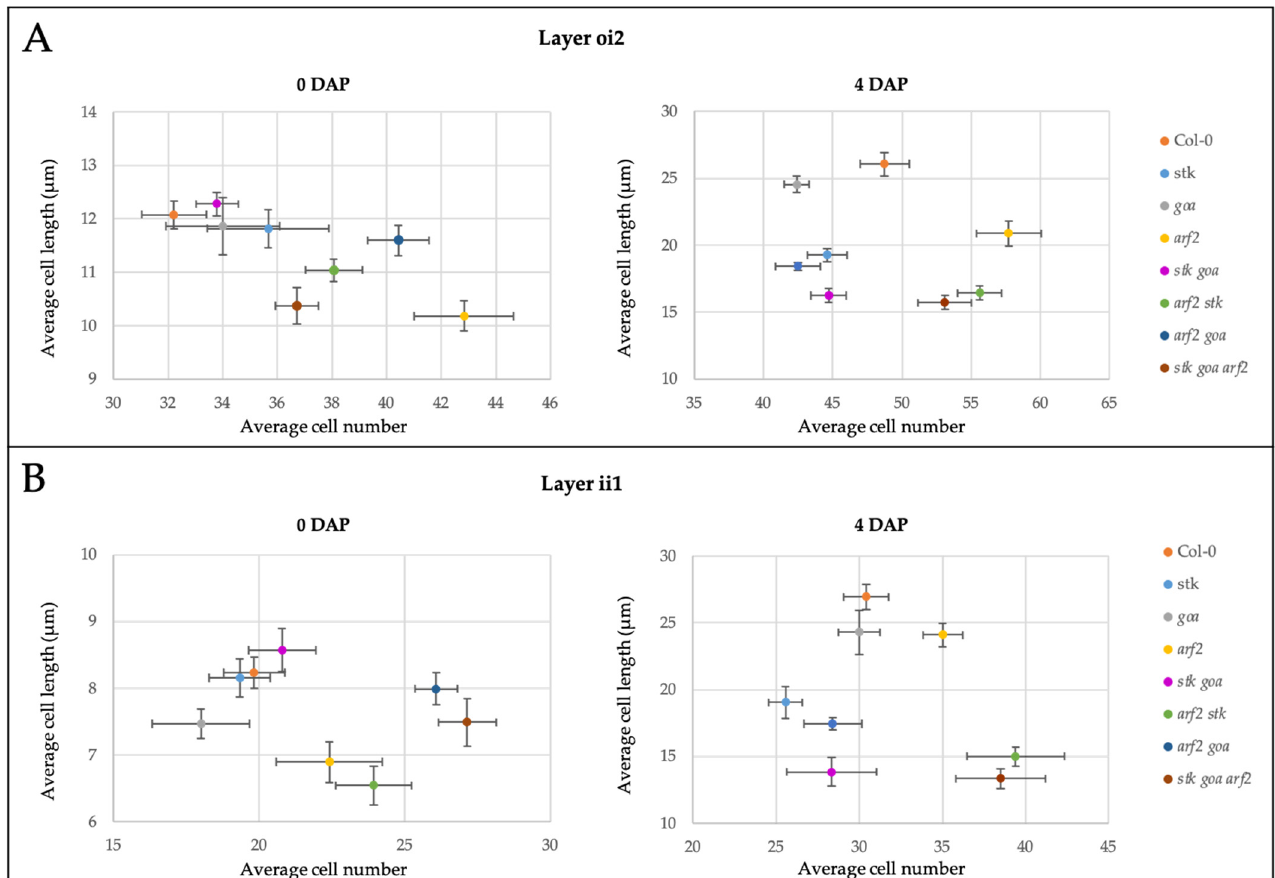
Figure 2. Maternal control of seed coat development. Size distribution of cell number (major axis) and cell length (minor axis) in oi2 ( A ) and ii1 ( B ) layers in ovules (0 DAP) and in seeds derived from crosses with WT pollen (4 DAP). Each dot represents a mean of at least 6 seeds. Error bars represent s.e.